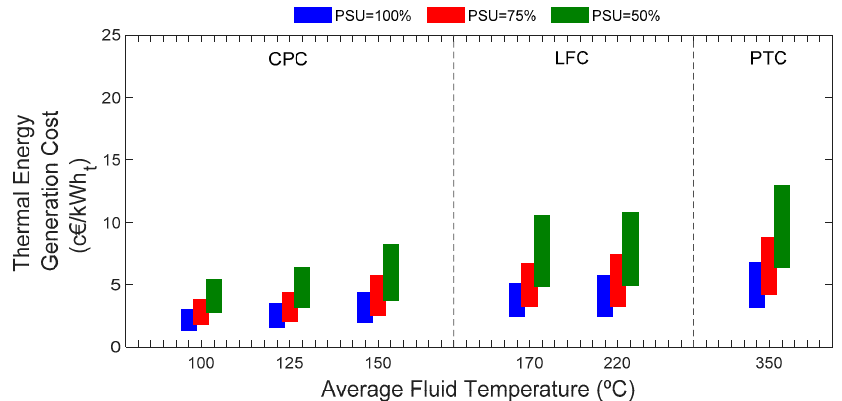
Figure 10. Thermal energy generation cost—Large size solar field area.